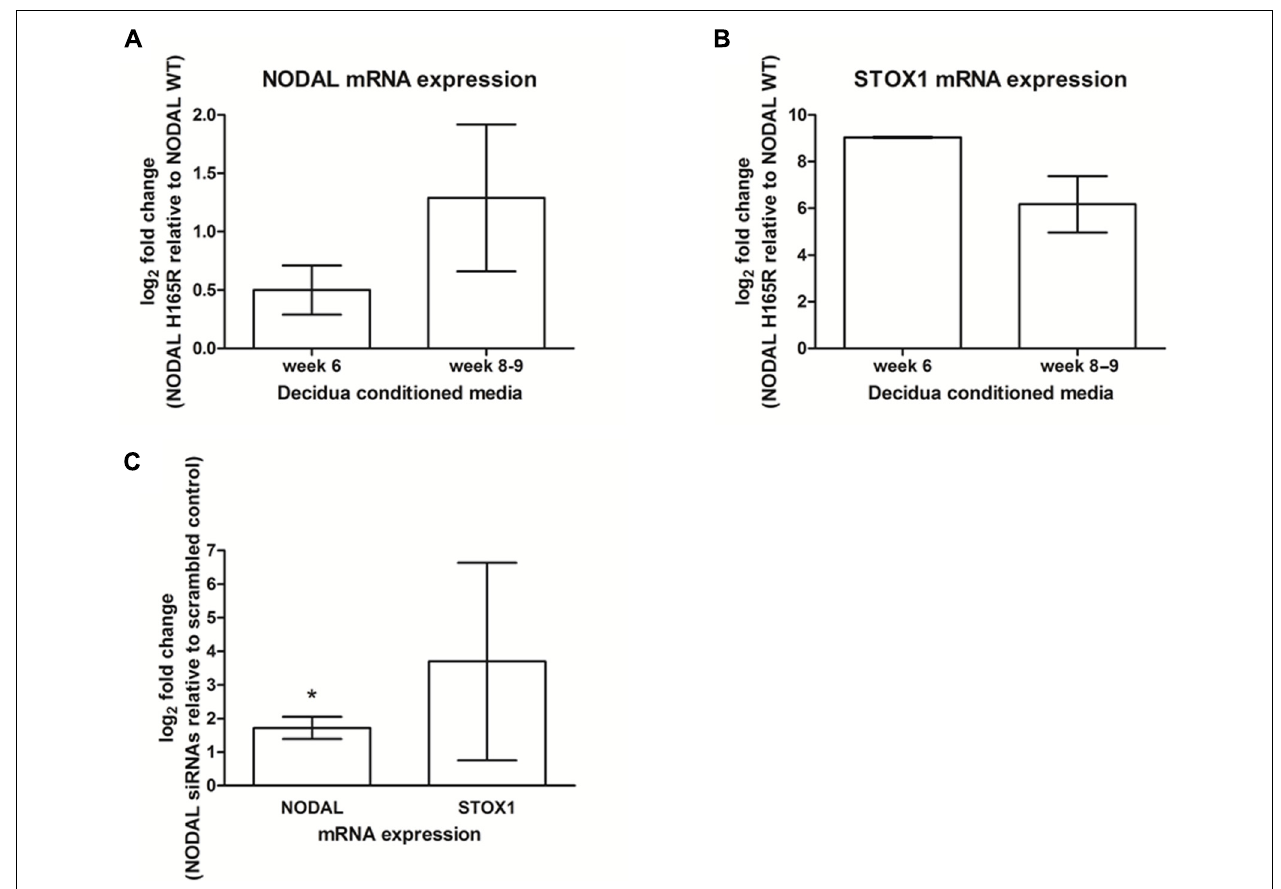
carrying Nodal H165R ( n = 2 per gestational age) relative to wildtype (WT; n = 2 per gestational age) alleles. (C) NODAL and STOX1 mRNA expression in SGHPL-5 cells treated with decidua conditioned media from deciduas treated with Nodal siRNAs relative to scrambled control ( n = 4). * P <